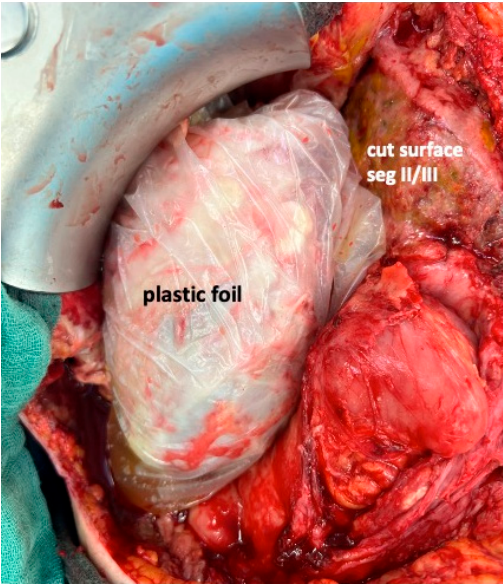
Figure 7. On re-exploration of the abdominal cavity, the plastic foil remains inert to the surrounding tissue and is easily removed, giving access to the remaining vasculature to the right liver lobe.